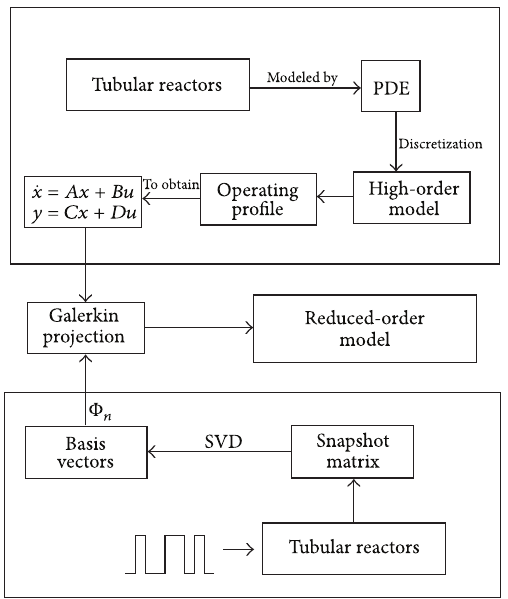
Figure 1: Model reduction